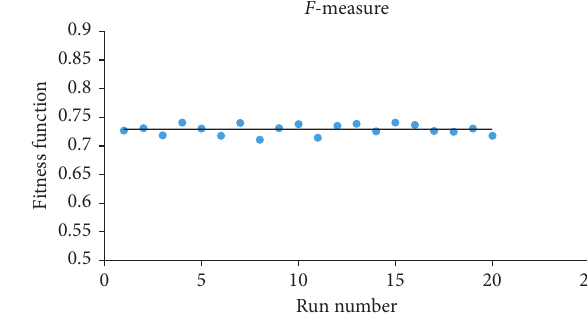
Figure 4: The F-measure stability diagram for the CYC2008 data Table 5: The Kolmogorov–Smirnov test for the Collins data sample (CYC2008).